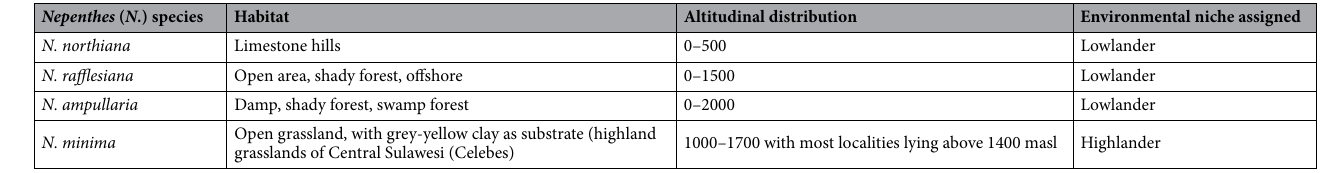
Table 2. Four Nepenthes species employed in this